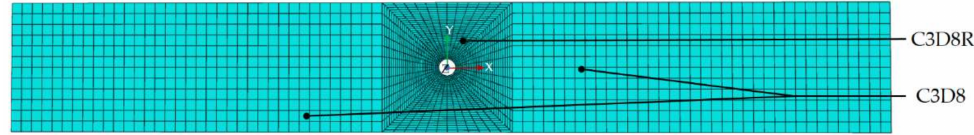
Figure 2. Finite element meshes of the centrally notched composite